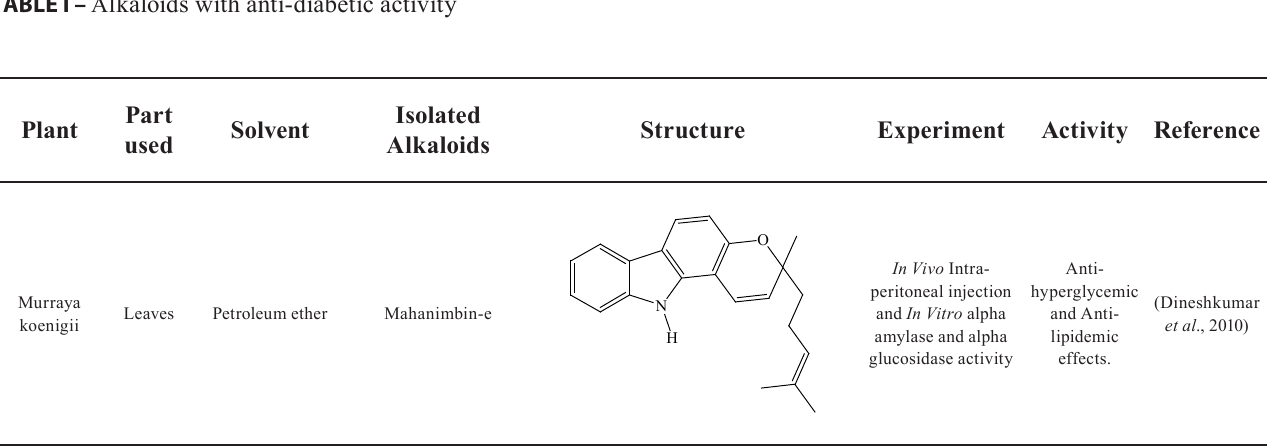
TABLE I – A lkaloids with anti-diabetic activity